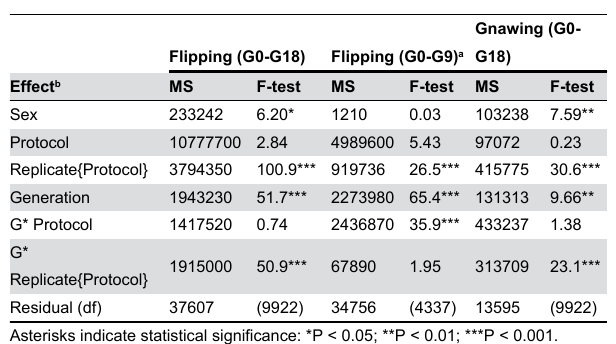
Table 3. Statistical tests (mean squares and appropriate F- tests from generalized linear models) of effects of sex, breeding protocol, replicate, and generation on stereotypic behavioral traits of Flipping and Gnawing.